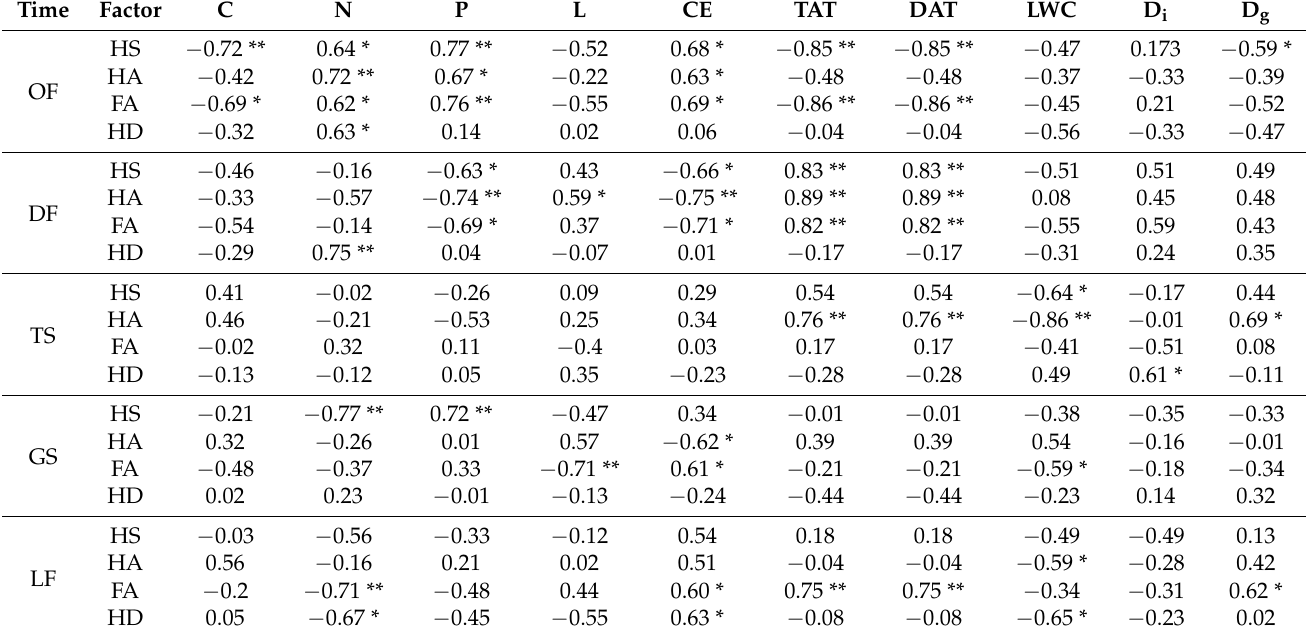
Table 2. Pearson correlation analysis of contribution rate of soil fauna to humic substances (HS), humic acid (HA), fulvic acid (FA) and humification degree (HD) and C, N, P, lignin (L), cellulose (CE), total accumulated temperature (TAT), daily average temperature (DAT), litter water content (LWC), soil fauna individual density (D i ), and group density (D g ) at different stages. OF: onset of